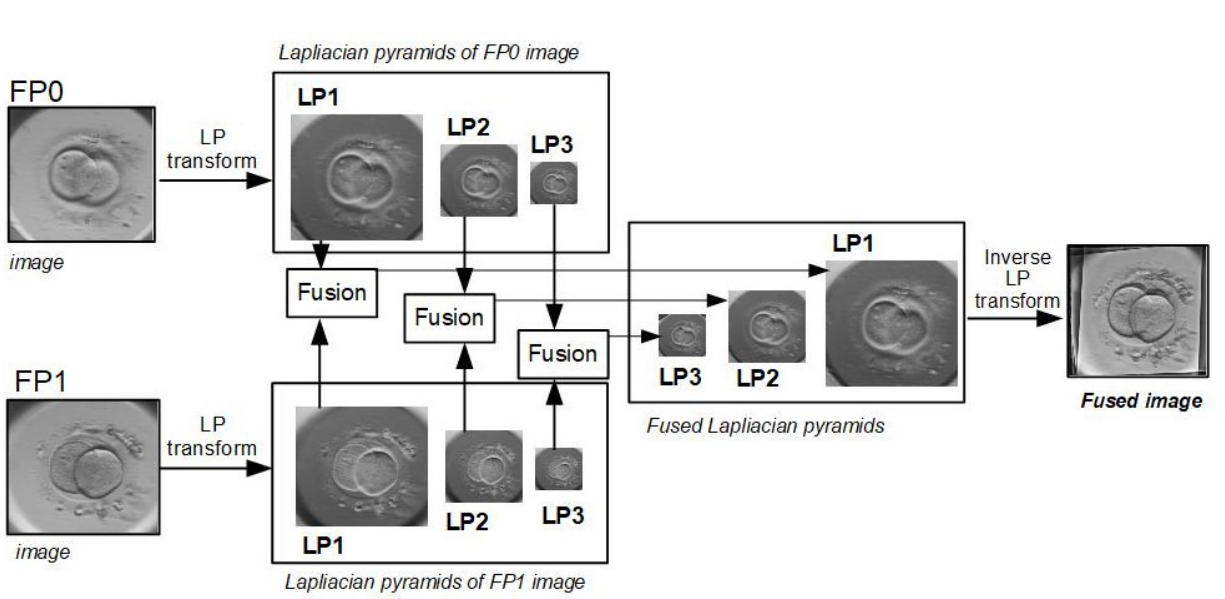
Figure 5. The framework of fusion method based on Laplacian Pyramid